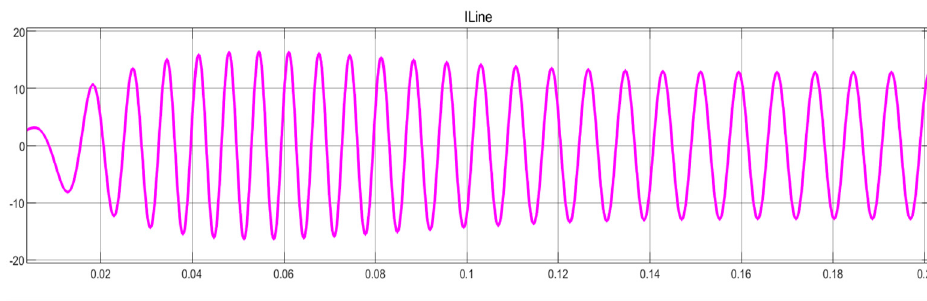
Inventions 2021 , 6 , x FOR PEER REVIEW